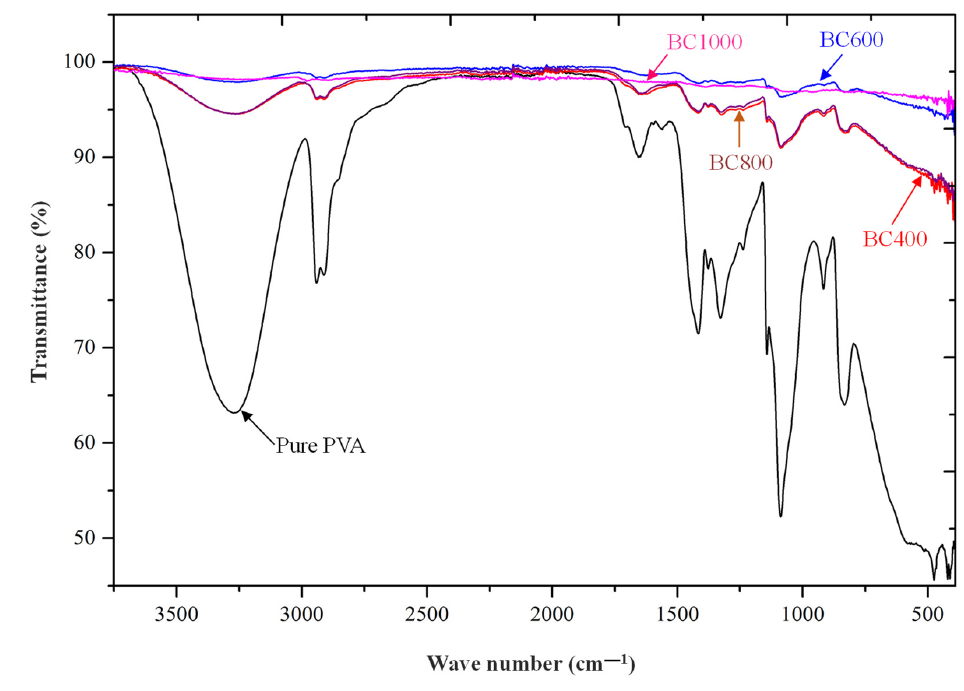
Figure 6. FTIR spectrum of biochar reinforced biocomposite films.